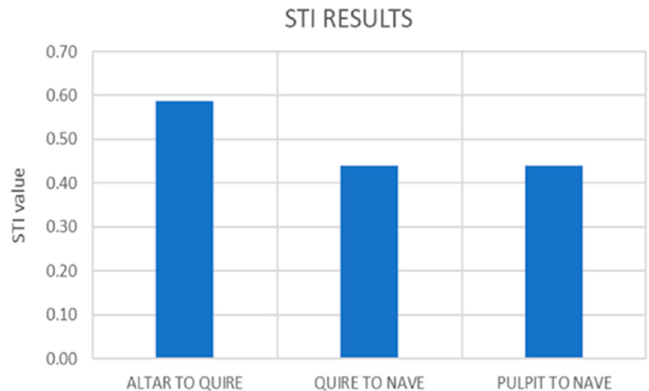
Figure 12. STI results for the simulated scenarios.